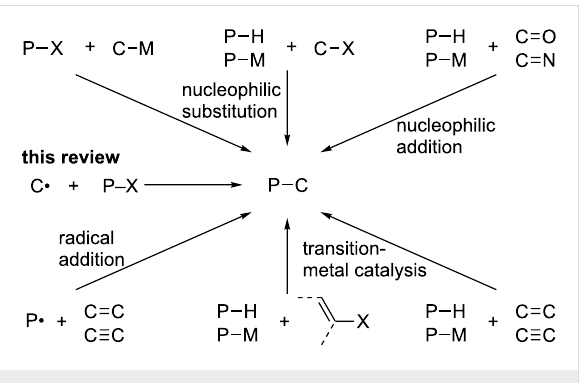
Scheme 1: Representative C–P bond-forming